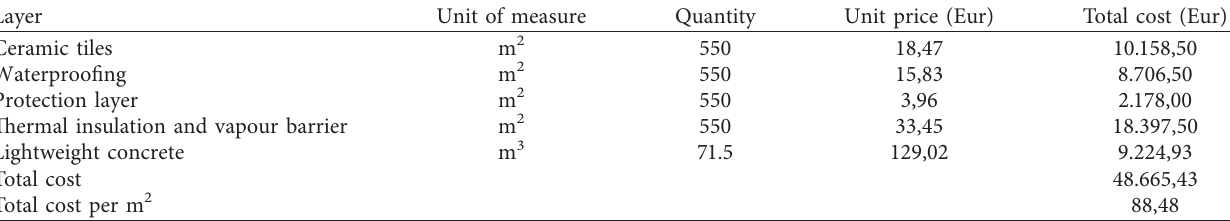
Table 6: Conventional flat roof construction costs (the table is structured by authors upon data collected from cost estimate for the building under construction).